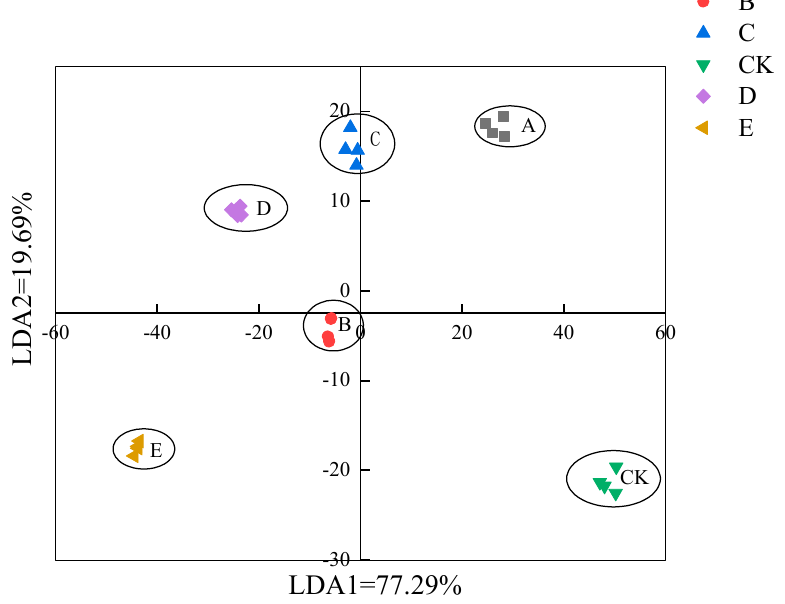
Figure 9. LDA of E − Nose response to crucian carp muscle at different vanillin treatment concentrations. Note: A, B, C, CK, D, and E represent vanillin concentrations of 0.50, 0.75, 1.00, 0 (control), 1.25, and 1.50 g/L, respectively.